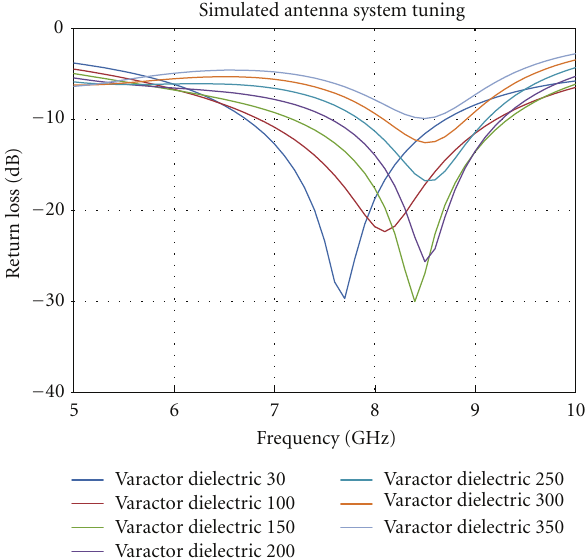
Figure 8: Simulated susceptance versus frequency for the antenna system.